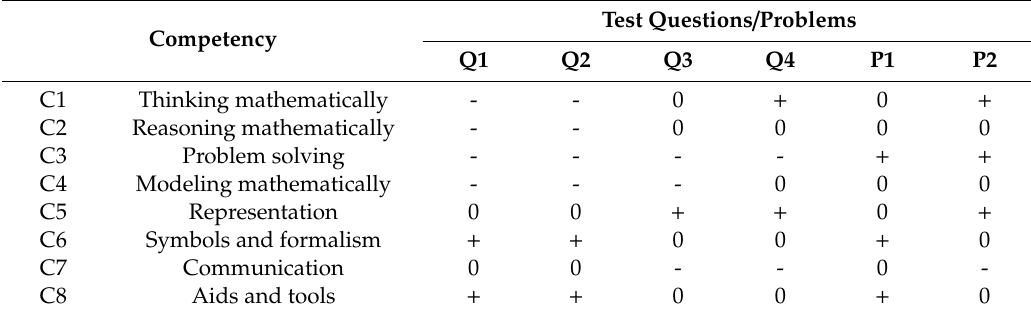
Table 2. Correspondence between competencies and the test elements 1